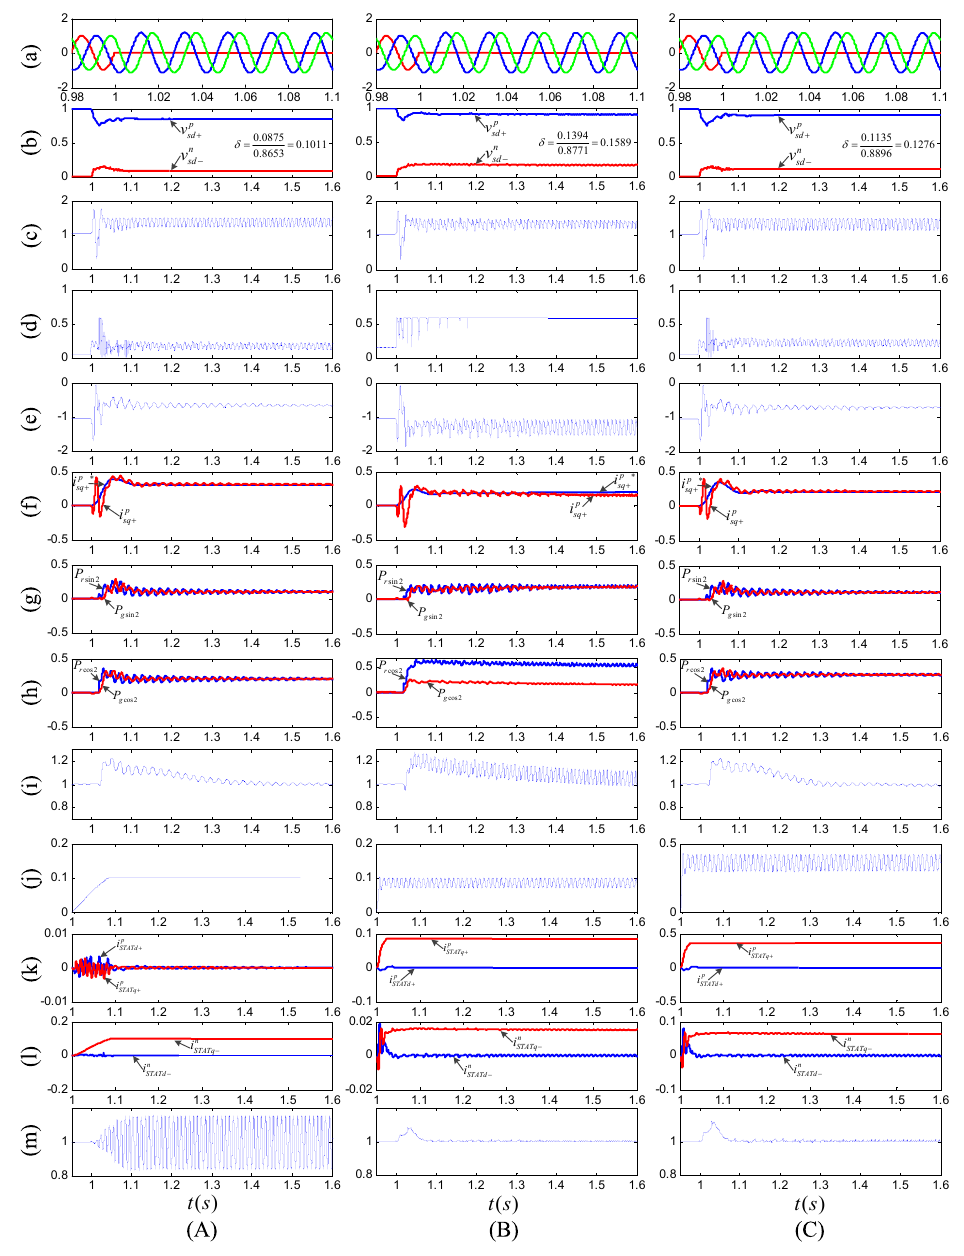
Figure 11. Simulation results of the DFIG-based wind farm with STATCOM compensation during asymmetrical grid faults: ( a ) three-phase voltages at GCP (pu); ( b ) magnitudes of positive- and negative-sequence stator voltages (pu); ( c ) magnitude of rotor current | (pu); ( d ) magnitude of rotor voltage space vector | (cid:126)v (cid:48) | (pu); space vector | (cid:126)i (cid:48) rαβ rαβ ( e ) electromagnetic torque T (pu); ( f ) positive-sequence stator reactive current (pu); e ( g ) and ( h ): magnitudes of active power oscillations on both sides of the DFIG system’s DC-bus (pu); ( i ) DC-link voltage of DFIG system V (pu); ( j ) magnitude of STATCOM dc | (pu); ( k ) positive-sequence components of STATCOM current current space vector | (cid:126)i STATαβ (pu); ( l ) negative-sequence components of STATCOM current (pu); and ( m ) the DC-link = (pu). ( A ) single-phase solidly-grounded fault ( Q voltage of STATCOM V STATrate dc STAT 0 . 1 pu, k = 0 ); ( B ) single-phase solidly-grounded fault ( Q = 0 . 1 pu, k = 1 ); and STATrate = 0 . 42 pu, k = 1 ( C ) single-phase solidly-grounded fault ( Q STATrate